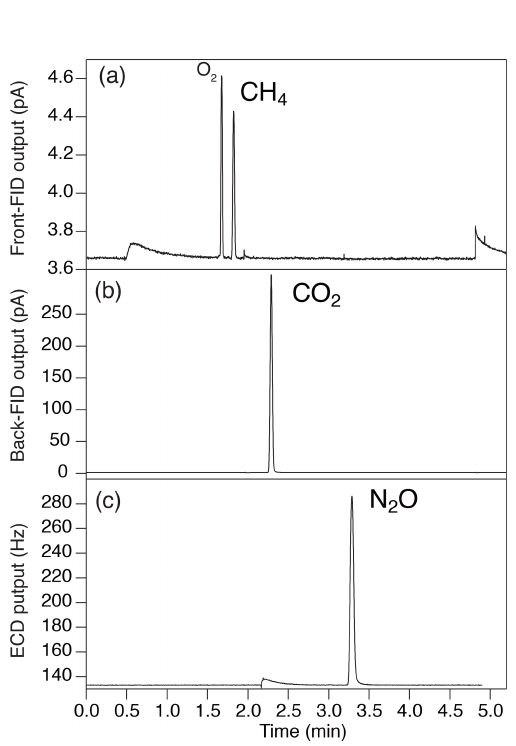
Figure 4. Typical chromatogram of (a) front FID for CH 4 (the largest peak is O 2 , and the second-largest peak is CH 4 ), (b) back FID for CO 2 and (c) ECD for N 2